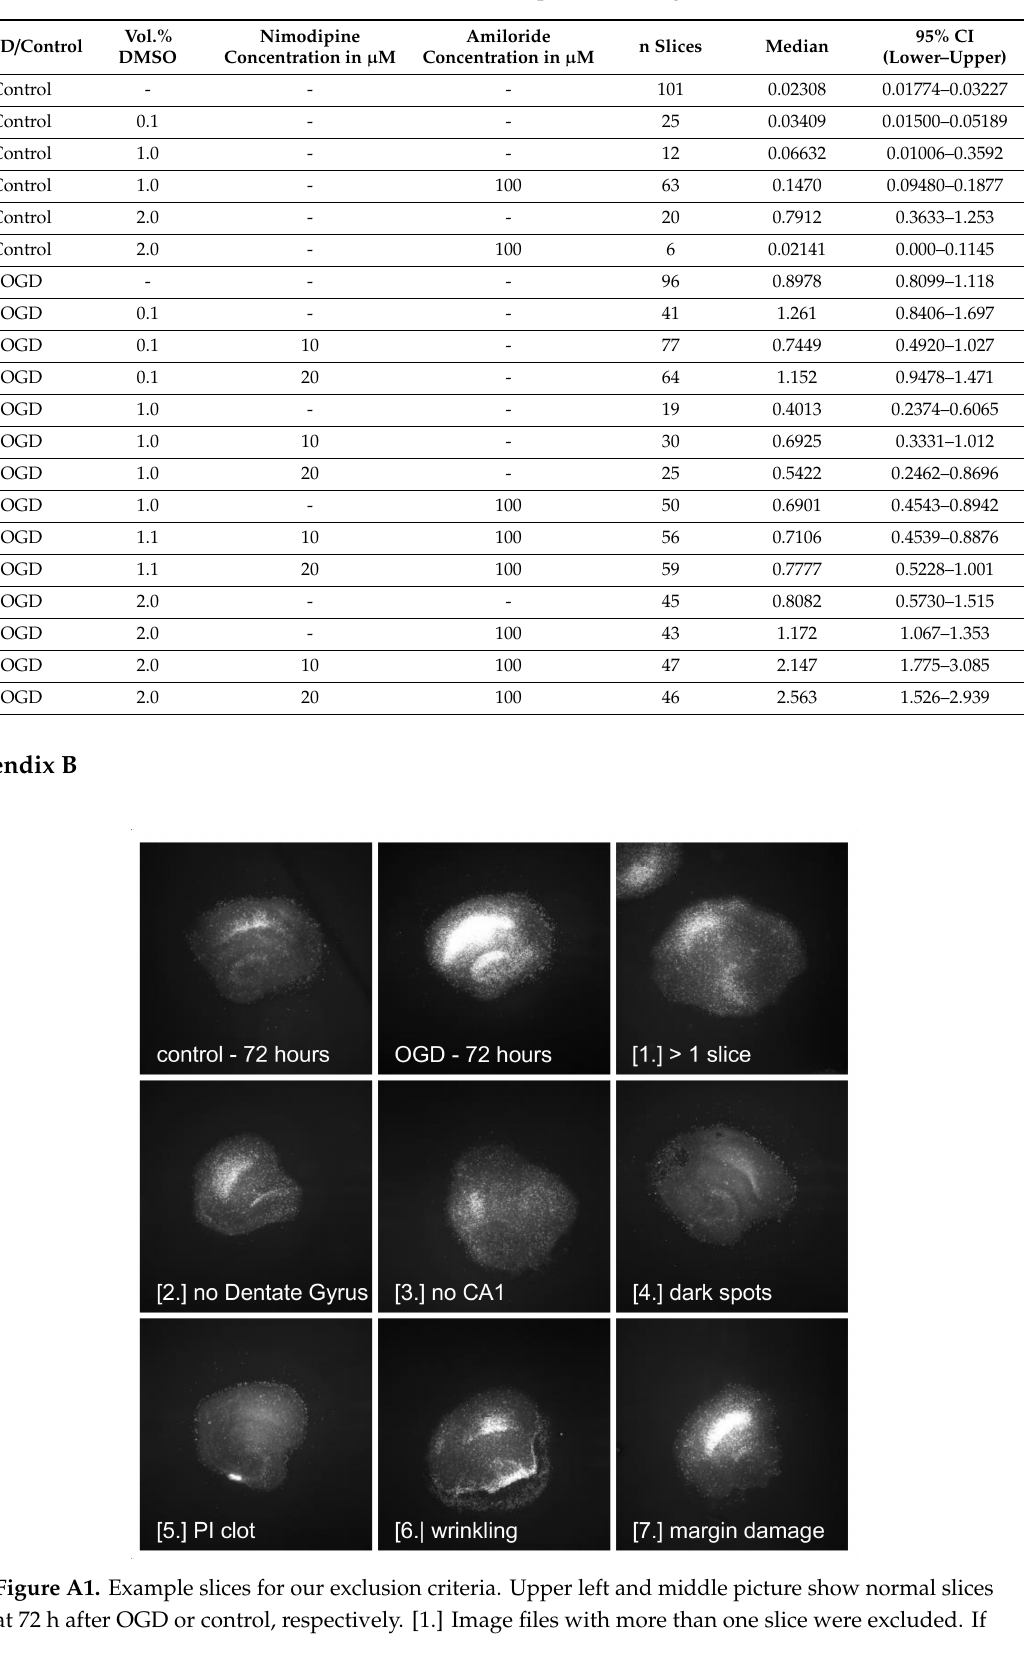
Table A1. Overview of all experimental regimes.